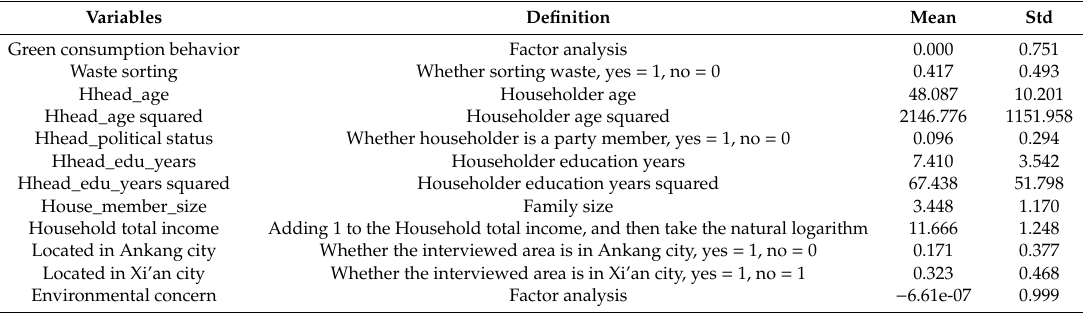
Table 1. Variable definition and data description ( N =